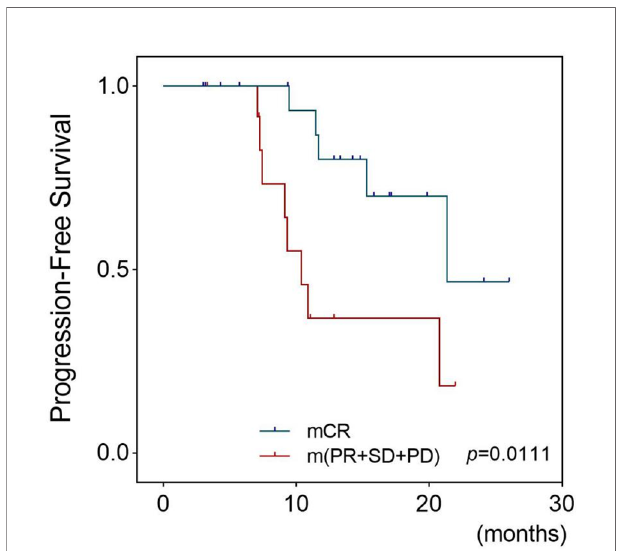
FIGURE 5 | Survival outcomes of patients whose PDX models had different platinum responses. This fi gure shows the Kaplan – Meier plots for progression-free survival of EOC patients who received chemotherapy based on platinum. Patients were divided into two groups: the mCR group whose corresponding models achieved mCR and the m(PR+SD+PD) group whose models were evaluated as mPR, mSD, or mPD. The Tick marks indicate censored data. p -values were estimated with the use of log-rank test based on the univariate analysis. PDX, patient-derived xenograft; EOC, epithelial ovarian cancer; mCR, modi fi ed complete response; mPR, modi fi ed partial response; mSD, modi fi ed stable disease; mPD, modi fi ed progressive